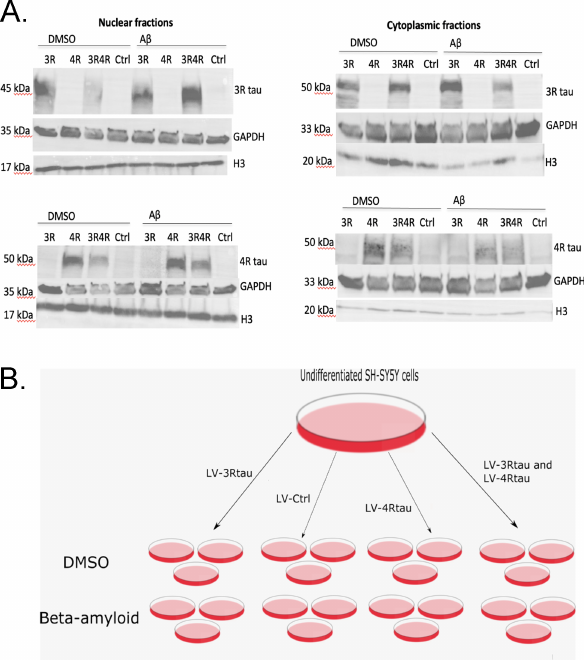
Fig 1. Validation of a typical infection and treatment workflow. (A) Use of tau isoform-specific antibodies in Western blotting demonstrates tau isoform-specific overexpression in both nuclear and cytoplasmic fractions as a result of infection with tau lentiviruses (N = 1). (B) A typical workflow for infecting cells with N = 3. Cells were treated with 50nM A β or DMSO 24 hours before collection.